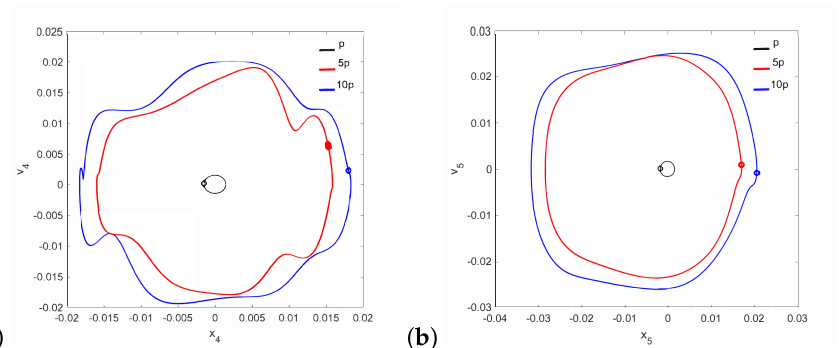
Figure 13. Phase diagrams of FMT motion in the pathological ear for γ 24 = 2 × 10 6 : the can ( a ) and the magnet ( b ).